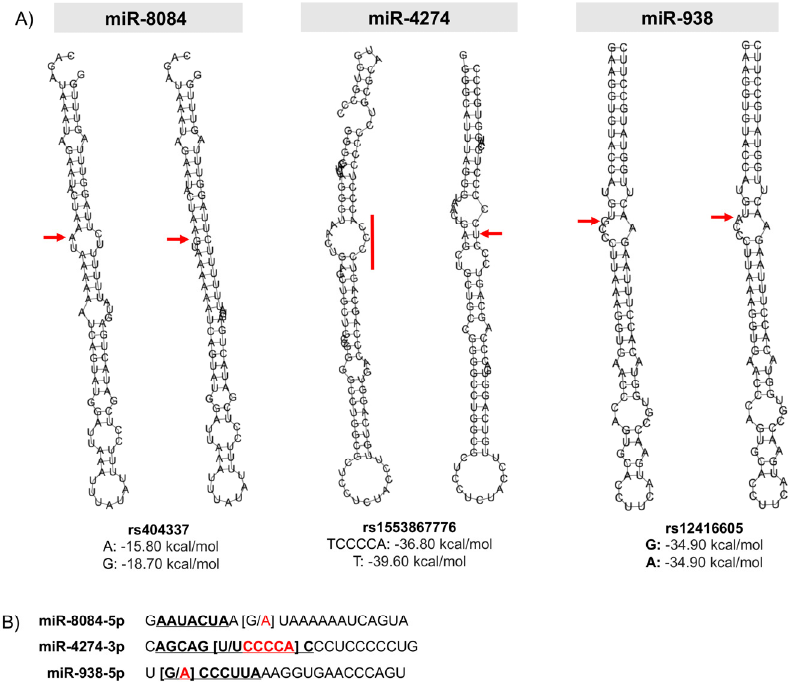
Figure 3. Secondary structure modeling of genetic variants in mature miRNAs. ( A ) The predicted structures of pre-miRNAs with common allele (left) and the variant (right) are shown. A red arrow indicates the position of the allele. The free energies of both alleles are also shown. ( B ) The sequence of the mature miRNA is shown in bold, and the seed region is underlined.